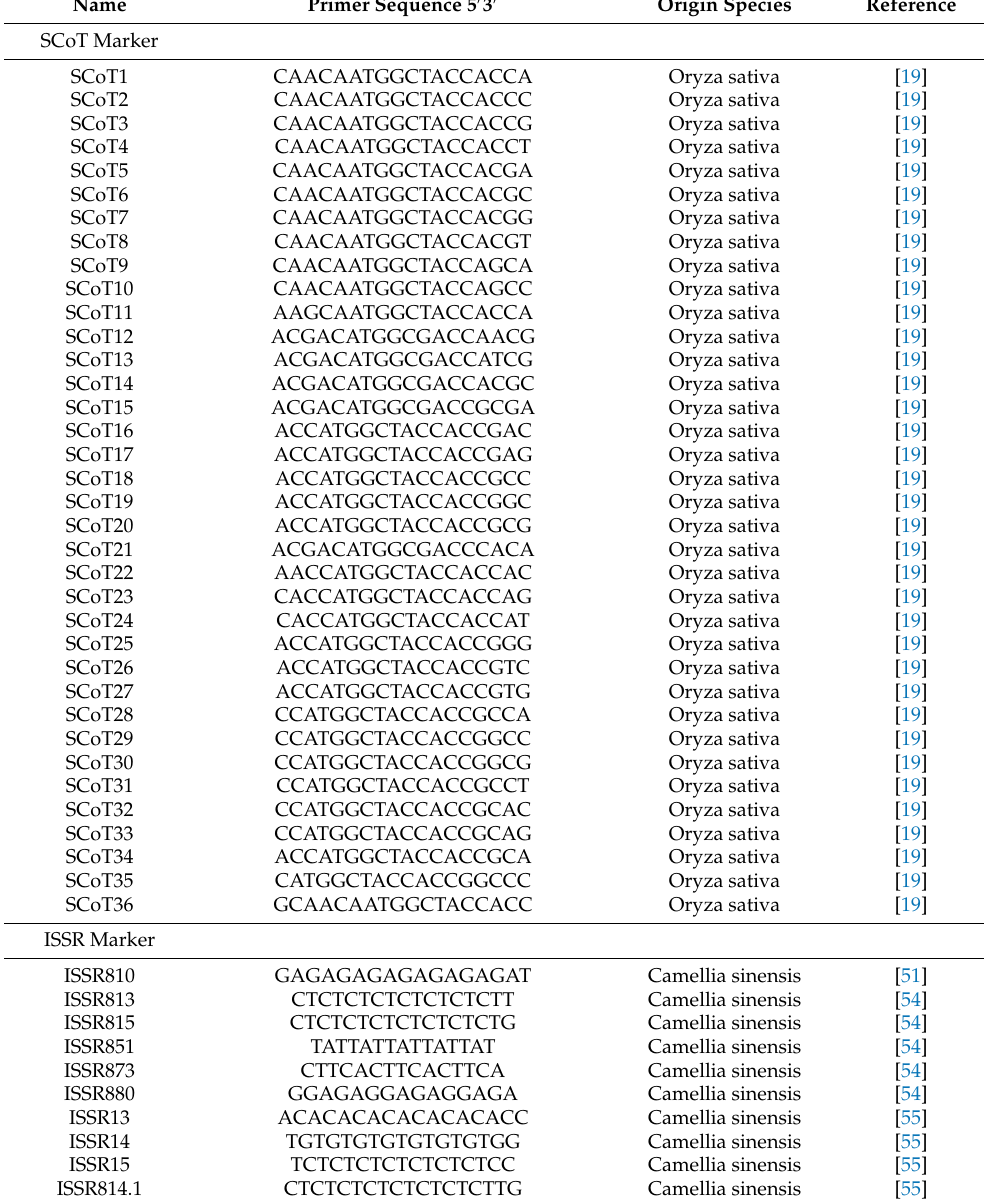
Table 3. ISSR, SCoT, and SSR primers used for the genetic analysis of the chrysanthemum germplasm collection. The most efficient ones are marked in